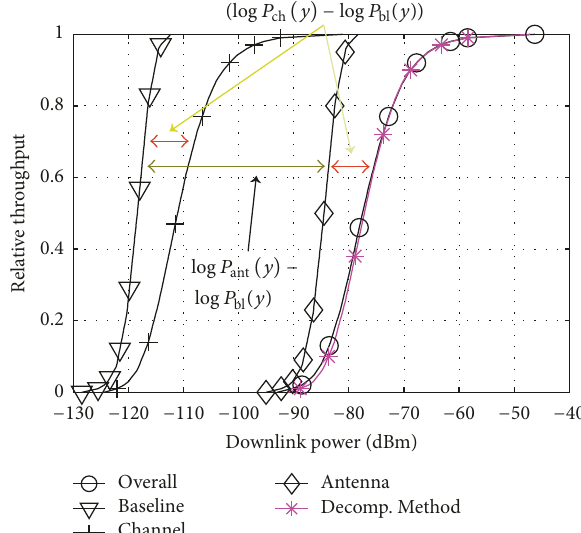
Figure 4: Result of the DM (relative throughput versus downlink power): adding up the logarithmic results of the “baseline”; “chan- nel”; and “antenna” measurements. Multiply all formulas by 10 for results in